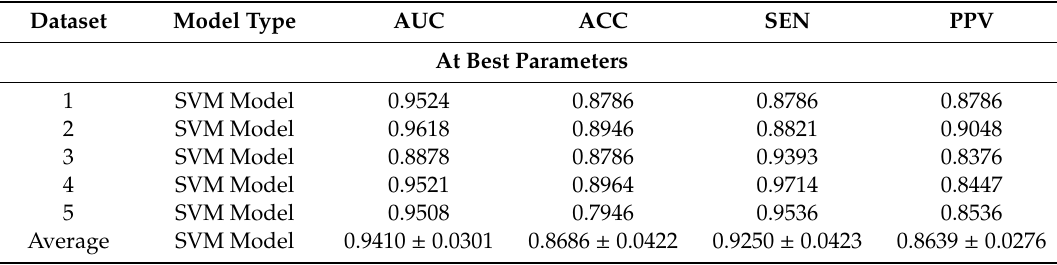
Table 5. The ROC curve analyses by test dataset for SVM models.